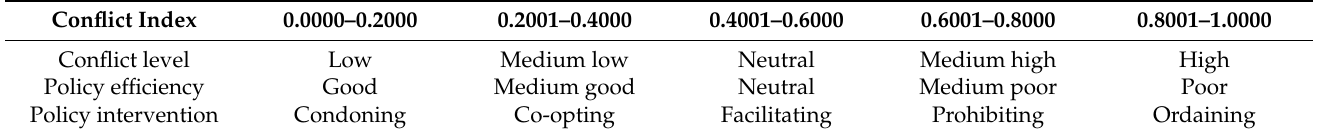
Table 6. Grading standards for conflict degree and